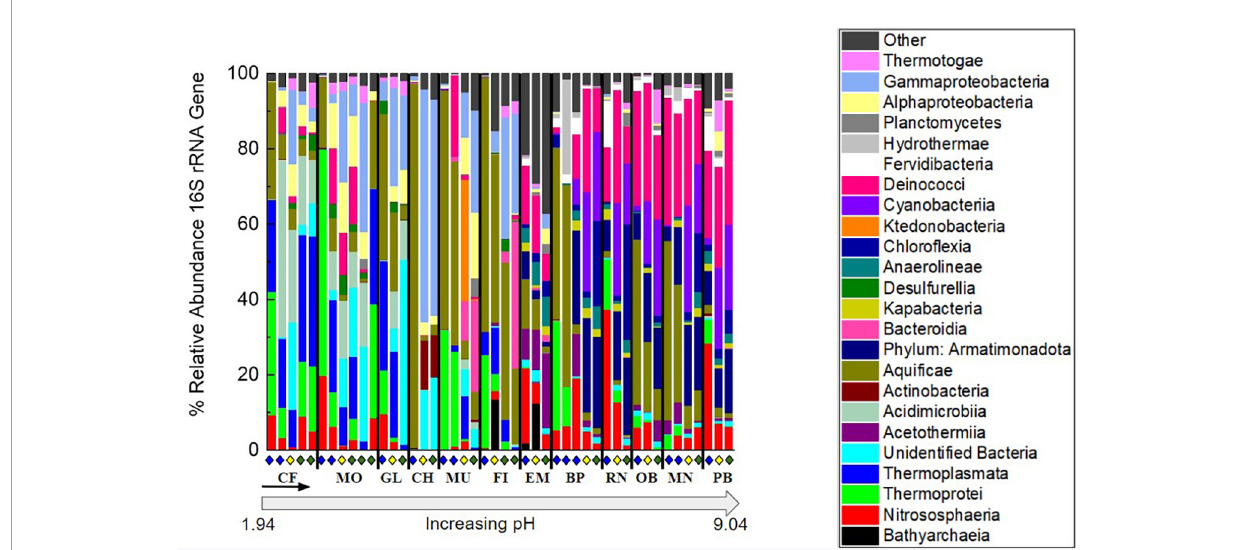
FIGURE3 Percent relative abundance of the 16S rRNA gene sequencing results to the class level except for Armatimonadota, which is at the phylum level, and unidentified bacteria, which were binned together at the domain level. To focus on abundant features and overarching patterns, classes not occurring at > 20% relative abundance when summed over all samples were binned into the “Other” category. Organization of hot spring sites, separated by black bars, follows the order of increasing pH shown in Supplementary Table 1 . Within each site, samples are organized down the outflow with above (blue diamond), at (yellow diamond), and below (green diamond) the photosynthetic fringe indicated as in Figure 1 .